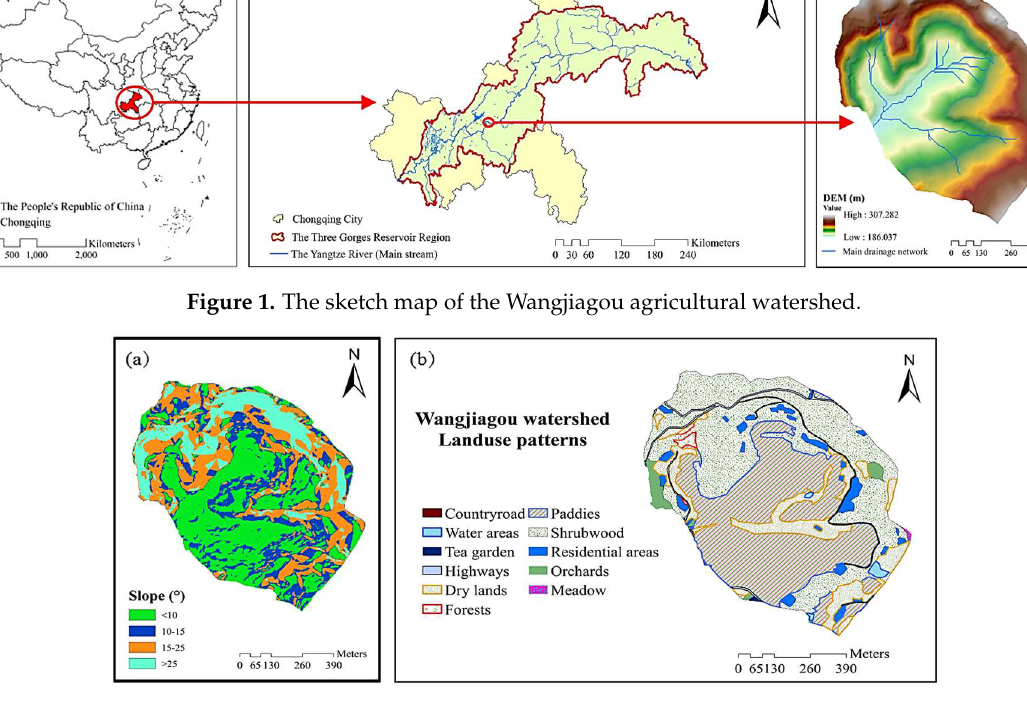
Figure 2. The slope ( a ) and land use patterns ( b ) in the Wangjiagou agricultural watershed.